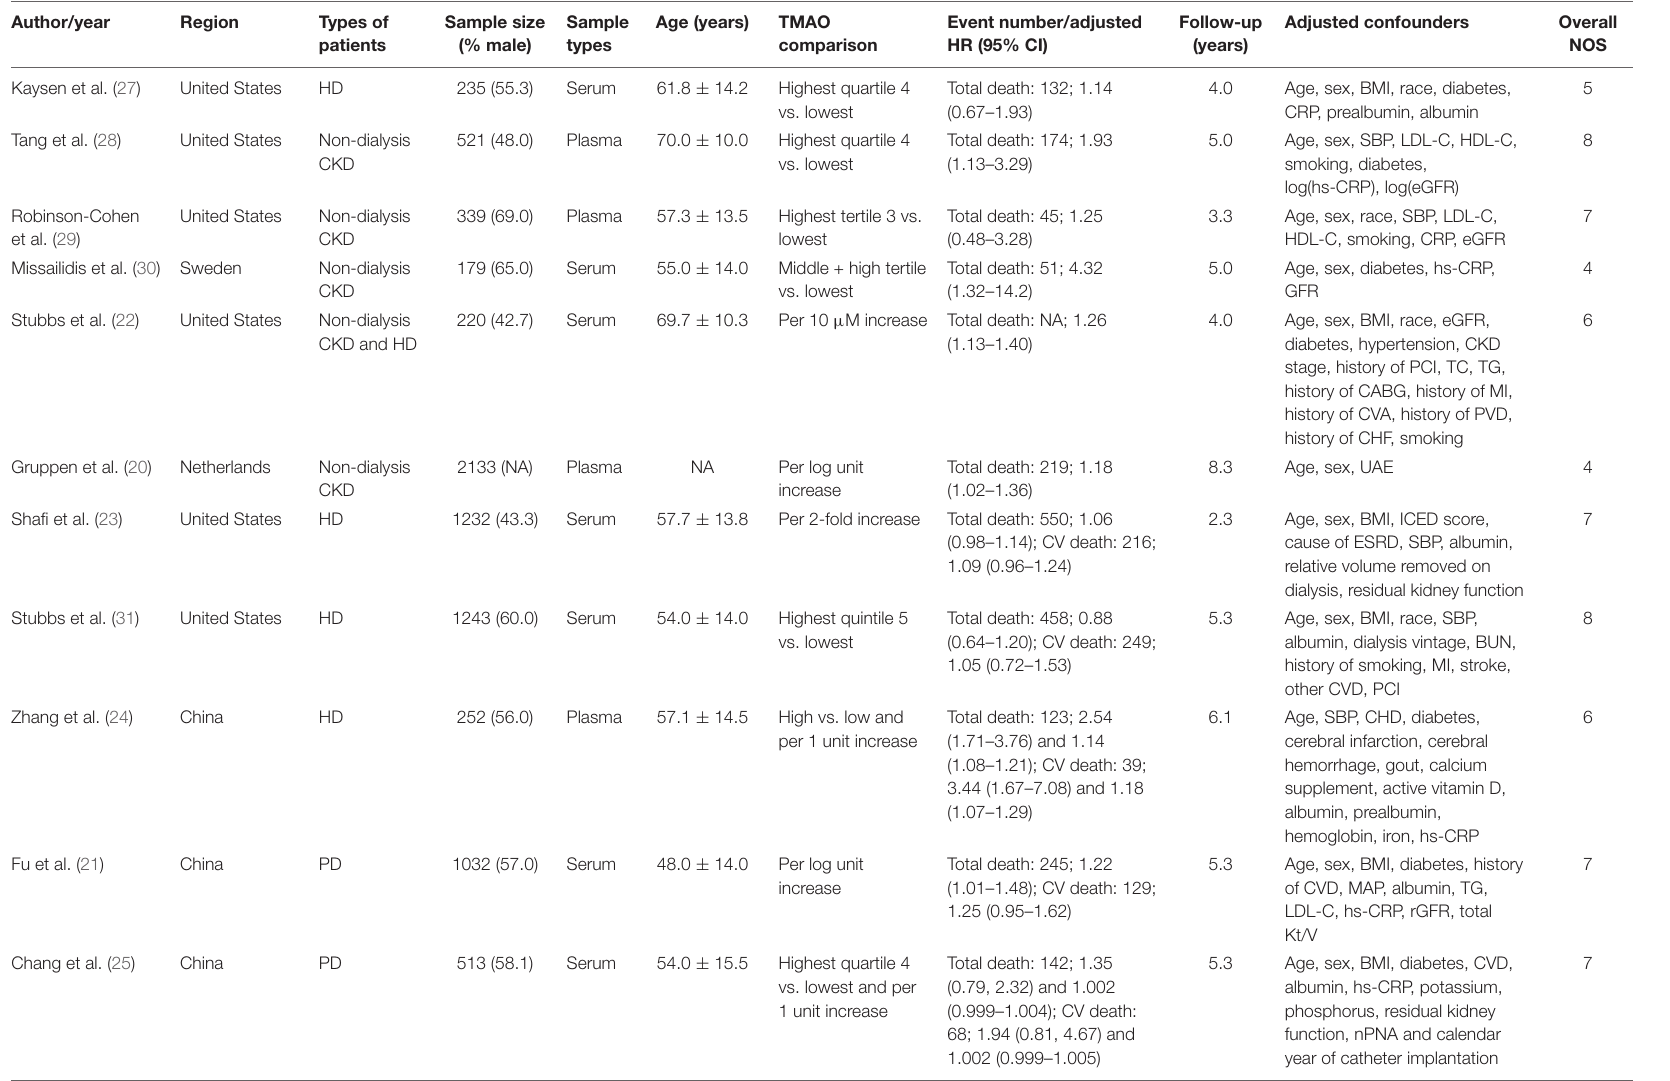
HR, hazard ratio; CI, confidence interval; SD, standard deviation; HD, hemodialysis; PD, peritoneal dialysis; CKD, chronic kidney disease; ESRD, end-stage renal disease; BMI, body mass index; TC, total cholesterol; TG, triglyceride; LDL-C, low density lipoprotein cholesterol; HDL-C, high-density lipoproteins cholesterol; BUN, Blood urea nitrogen; SBP, systolic blood pressure; CRP, C-reactive protein; hs-CRP, high-sensitivity C-reactive protein; GFR, glomerular filtration rate; eGFR, estimated glomerular filtration rate; rGFR, residual glomerular filtration rate; PCI, percutaneous coronary intervention; CABG, coronary artery bypass grafting; MI, myocardial infarction; CVA, cerebrovascular accident; PVD, peripheral vascular disease; CHF, congestive heart failure; UAE, urinary albumin excretion; ICED, Index of Coexistent Diseases; CVD, cardiovascular disease; MAP, mean arterial pressure; CHD, coronary heart disease; nPNA, protein equivalent of total nitrogen appearance normalized to body weight; NA, not available; NOS, Newcastle Ottawa